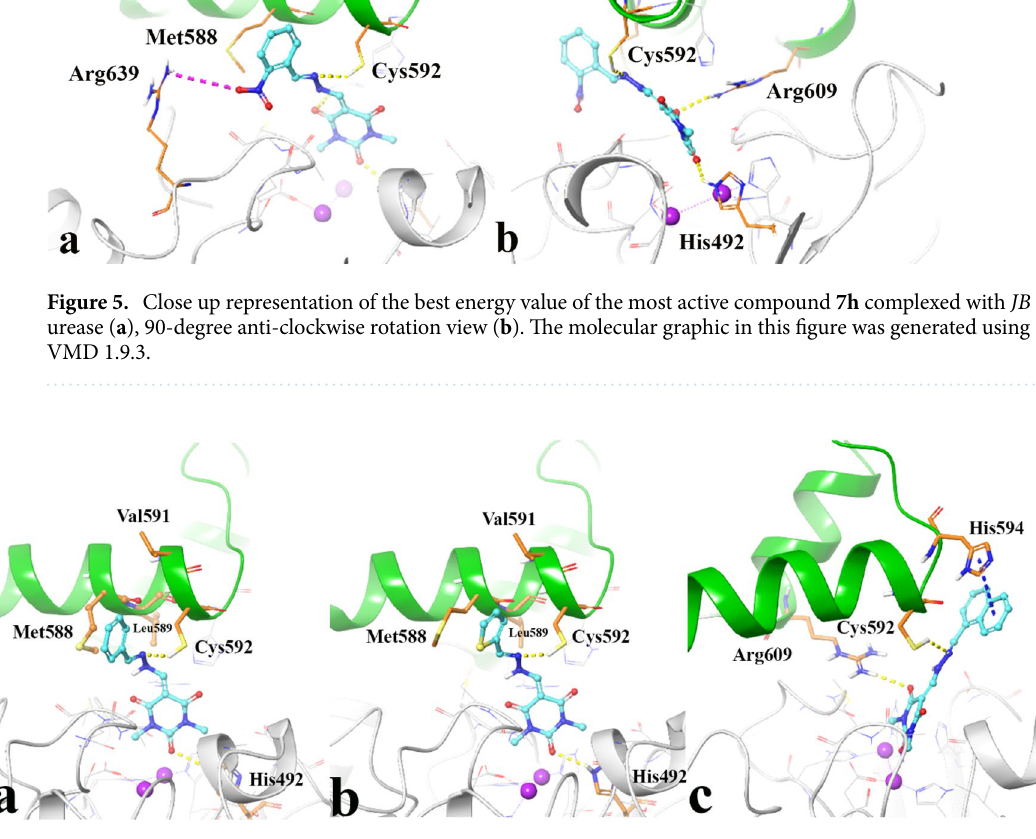
Figure 6. 3D representation of ligand-residue interactions of compound 7a ( a ), compound 7m ( b ), compound 7o ( c ) over urease active site. Active site flap colored in green. The molecular graphic in this figure was generated using VMD